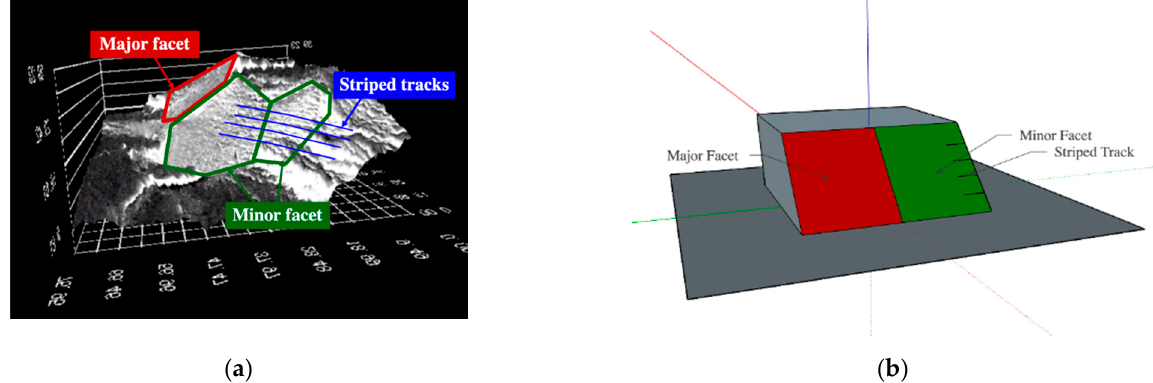
Figure 9. Example of the horizontal slope type. These facets are the same facets shown in Figure 6b ( σ max = 975 MPa, R = 0.1, N f = 4.5 × 10 6 ). ( a ) 3D-SEM image; ( b ) 3D-model schematic image.